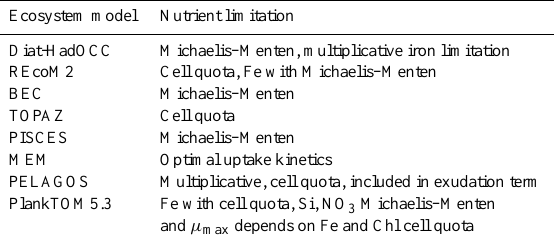
Table 4. Comparison of nutrient limitation of phytoplankton growth in ecosystem models.